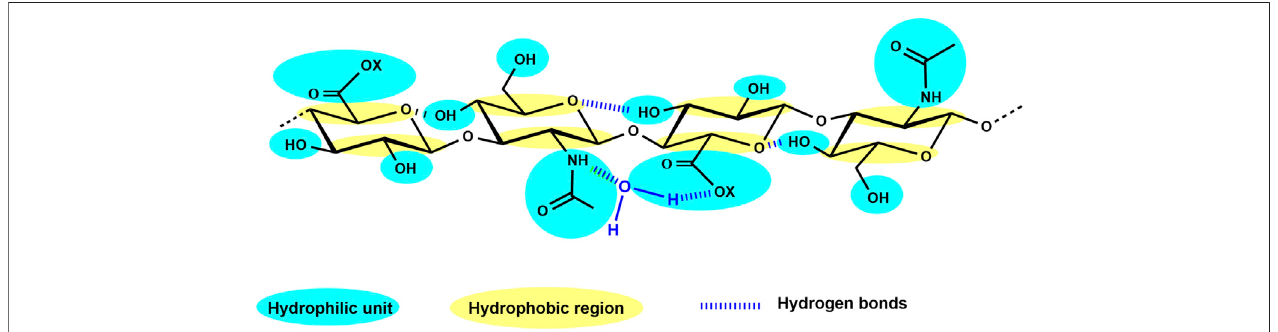
FIGURE 2 | HA tetrasaccharide unit schematically showing the hydrophilic moieties (in blue) and the hydrophobic regions (in yellow), while hydrogen bonds are represented by dark blue dashed lines (adapted from Fallacara et al., 2018, 10, 701).